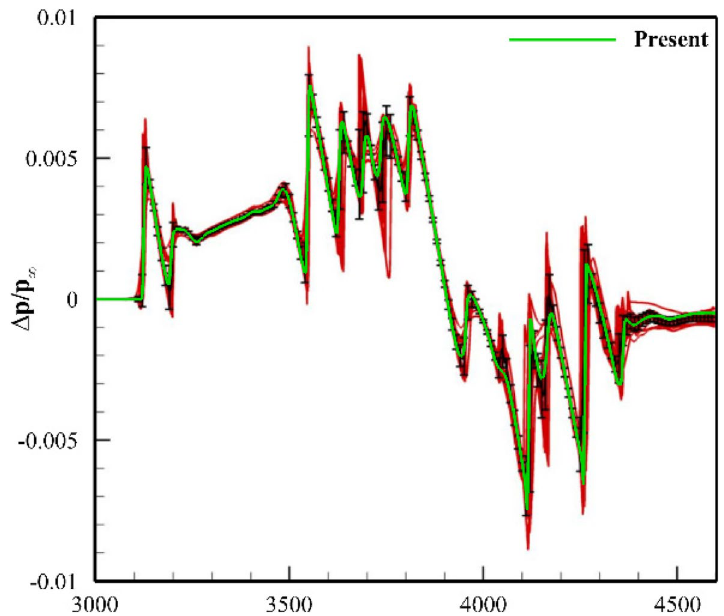
Fig. 8 Comparison between near-field overvoltage value distribution and SBPW-3